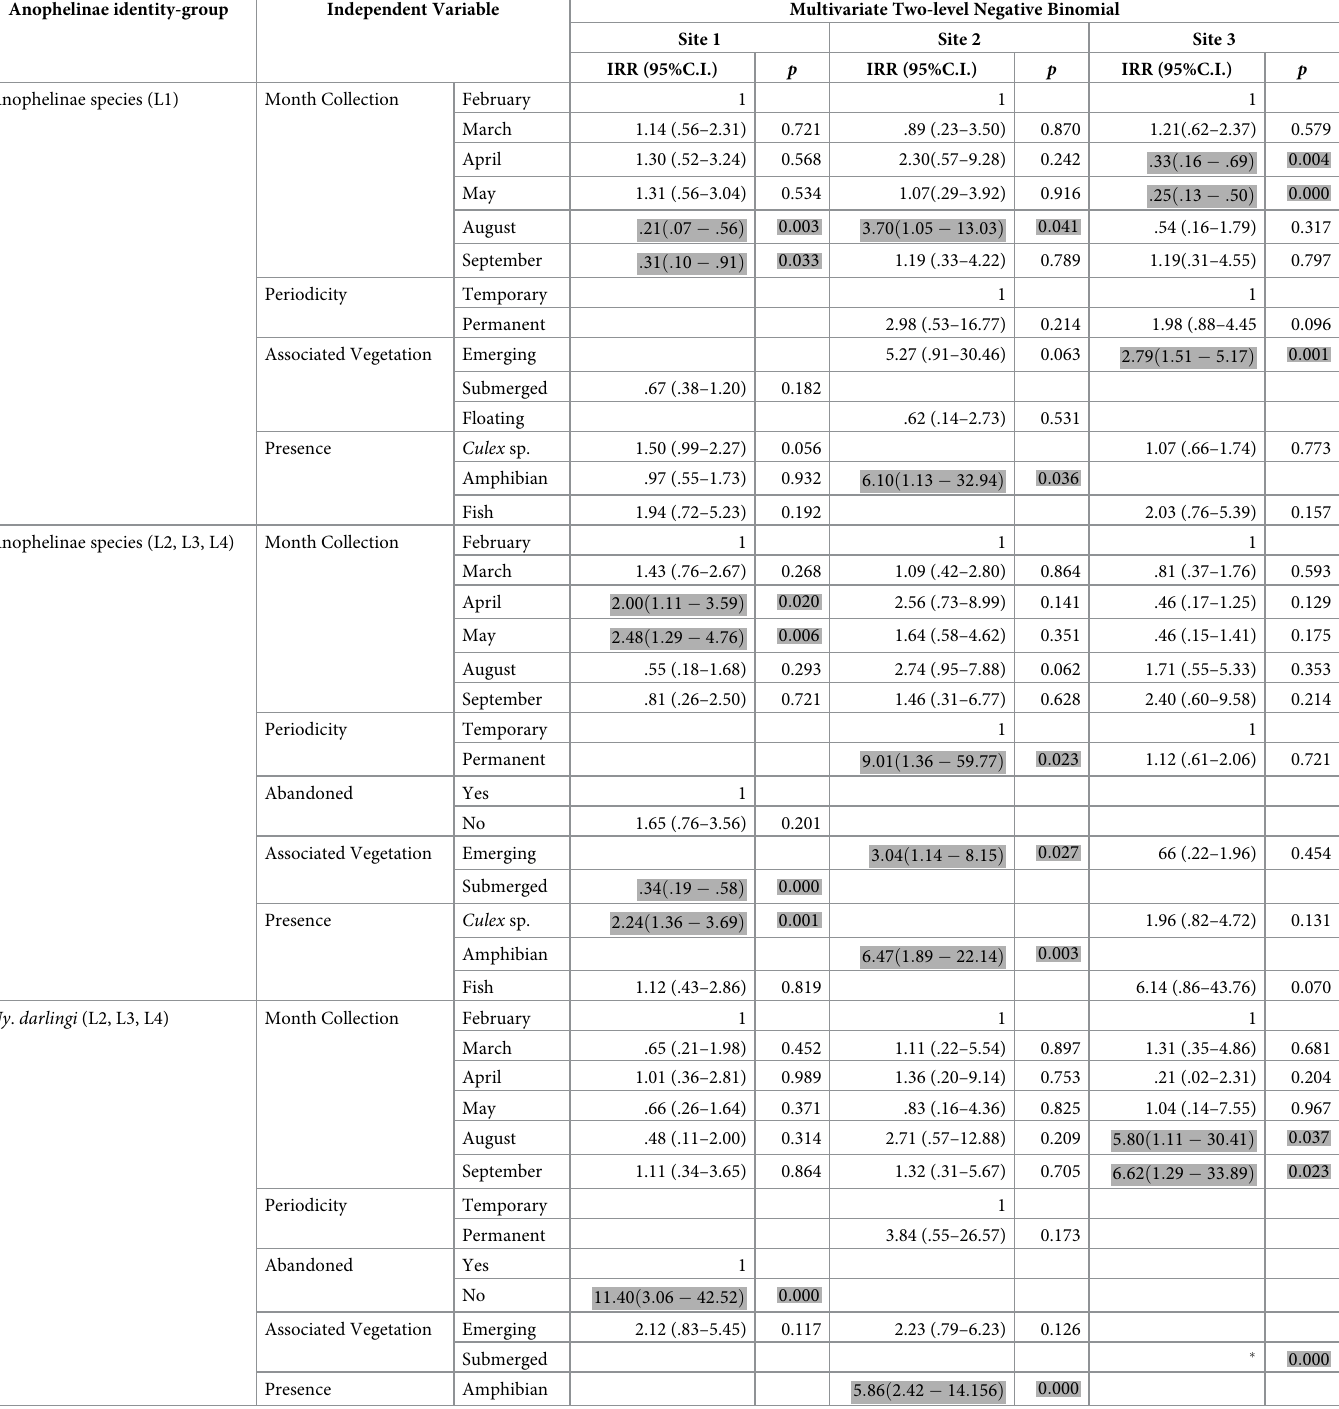
Table 2. Incidence Rate Ratio (IRR), 95% Confidence Interval and p values for Anophelinae species identity-group, for six-month survey multivariate two level neg- ative binomial regression. Anophelinae